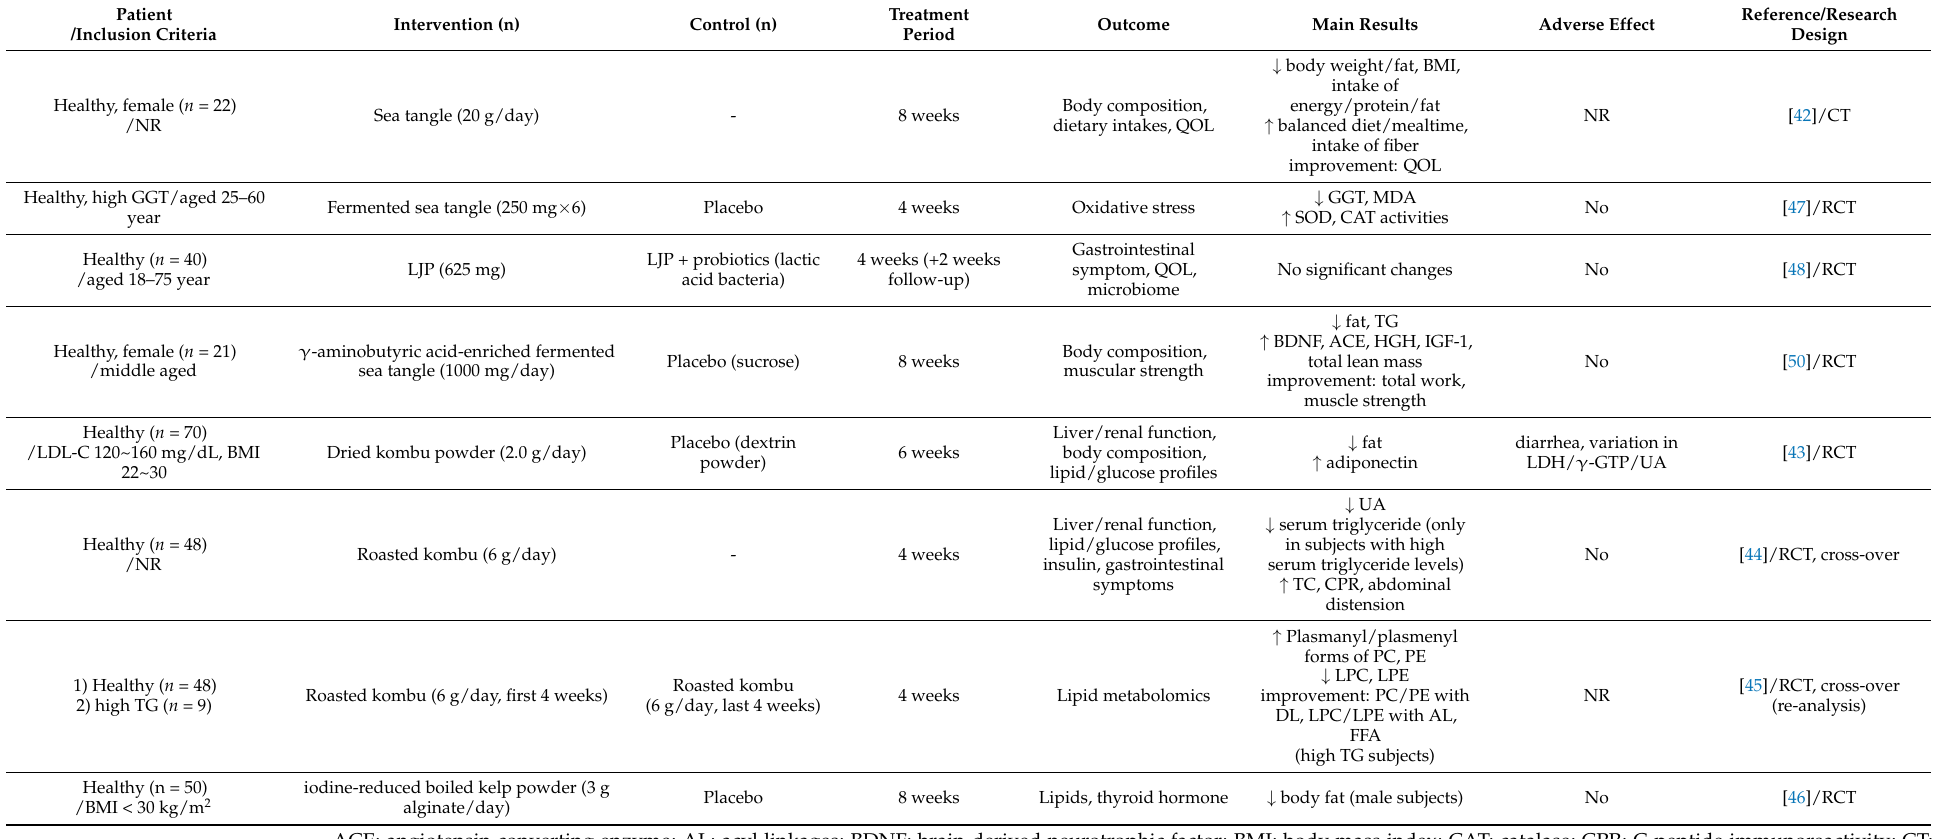
Table 5. An overview of the included clinical trials on the efficacy of LJP on metabolic